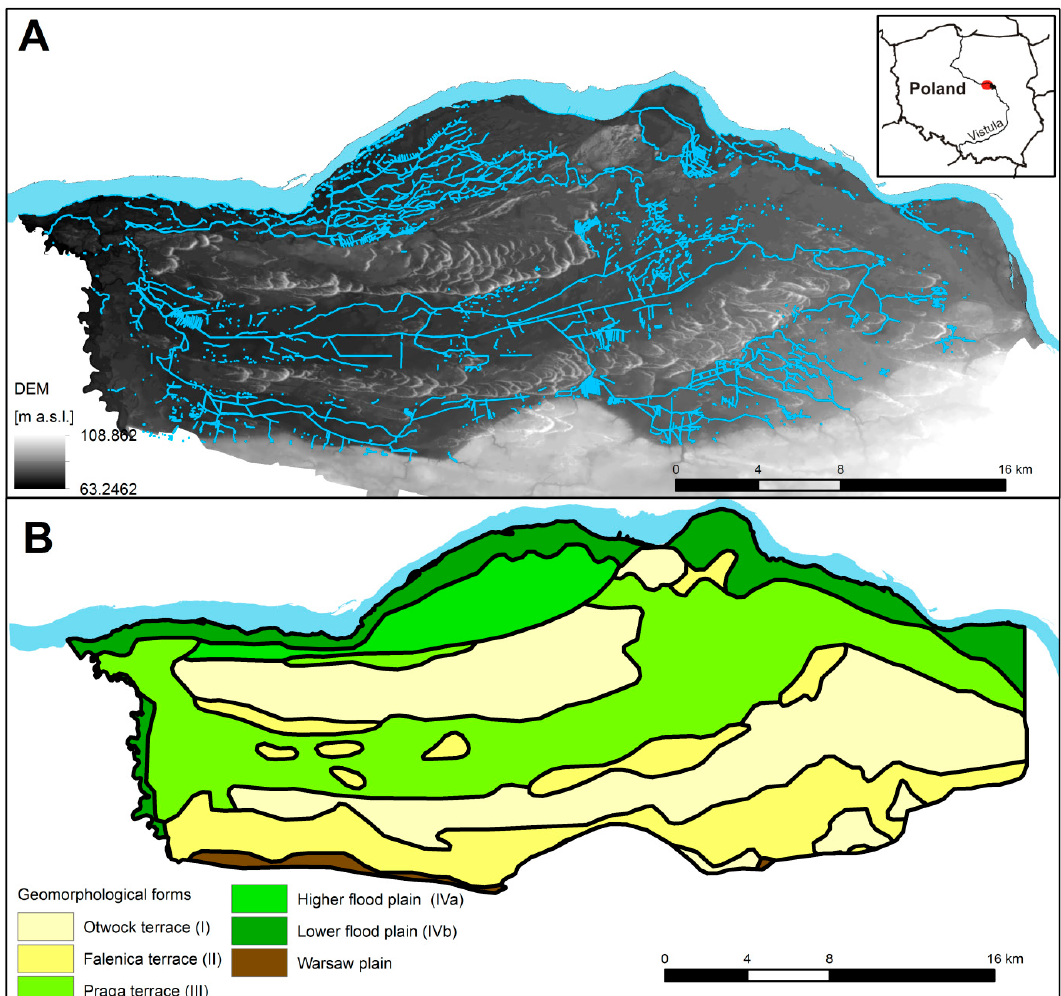
Figure 2. Study area characteristics: A – river network and morphology based on DEM 10 × 10 m; B – geomorphological units (adapted from [6,41]).